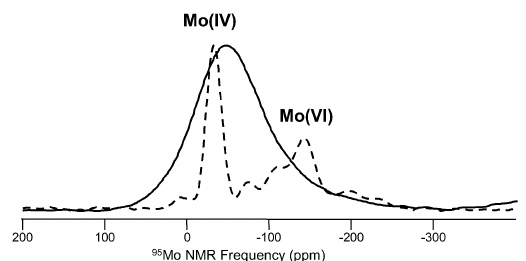
Figure 15. An example of 95 Mo MAS NMR from a mixed-alkali molybdate glass (33.3R 2 O · 66.7MoO 3 ), compared with data from polycrystalline Na 2 Mo 2 O 7 (dashed line) [93]. Comparisons with NMR data from known crystalline compounds are beneficial for understanding data from glasses. 95 Mo NMR peaks from tetrahedral and octahedral Mo are shown for Na 2 Mo 2 O 7 , and baseline “ripples” for these data are from truncation of the time-domain signal from incomplete acquisition of the full spin echo.